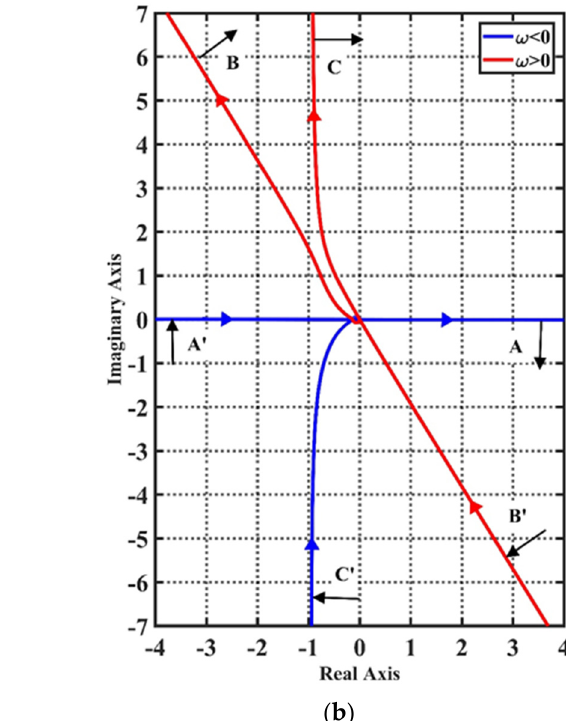
Figure 10. Inverse Nyquist diagram for Ω = 600 rad/s when Z s = − 2.2 mm. ( a ) Global; ( b ) Local. The inverse Nyquist curve turns 180 o clockwise from A to A (cid:48) , B to B (cid:48) and C to C (cid:48) with infinite radii. Thus, it circles ( − 1,j0 ) once.